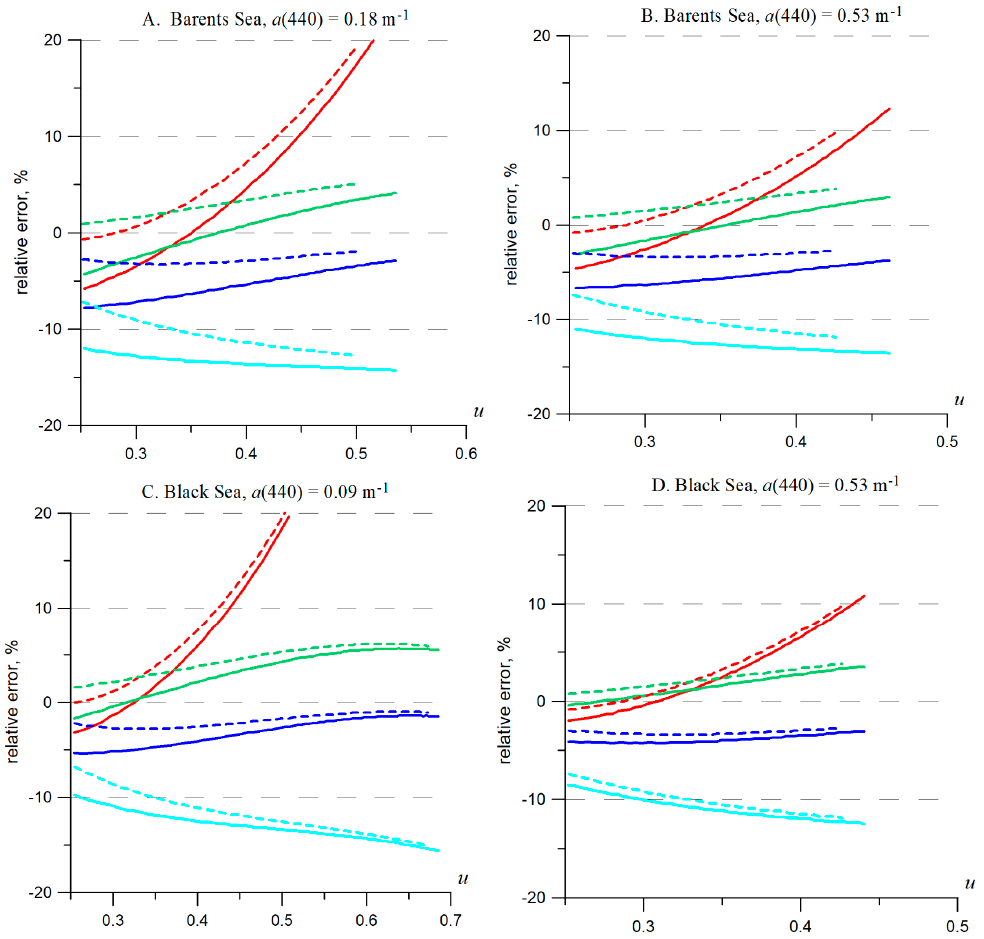
Figure 14. Relative errors of Equations (7)–(10), depending on the parameter u , taking into account the “non-coccolithophore” particles (dashed lines) and without it (solid lines). The color of the curves is the same as in Figure 13.